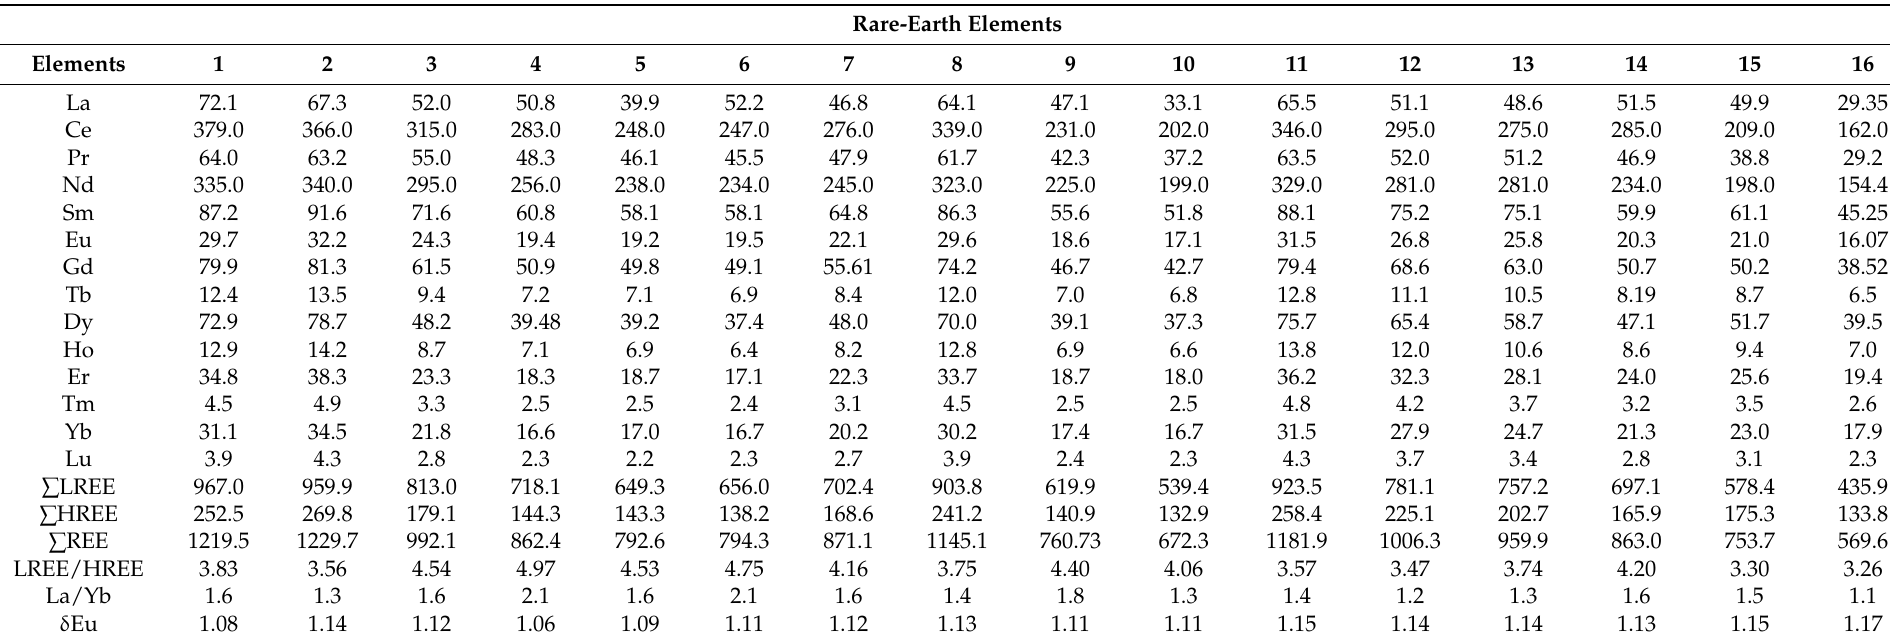
Table 2. LA-ICP-MS rare-earth and trace elements data (in ppm) of garnets from the carbonatite agglomeratic/brecciated intrusive,